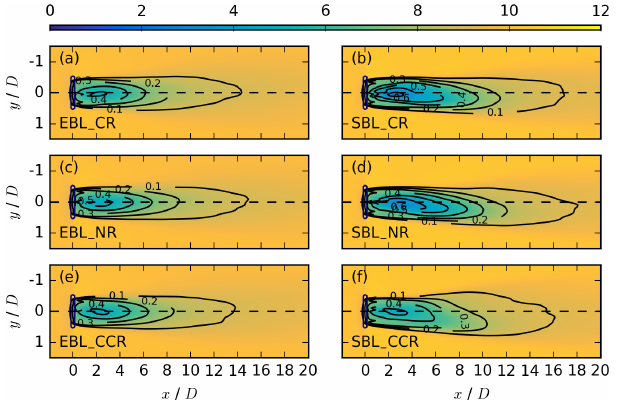
in Figure 9. Coloured contours of the streamwise velocity u i,j,k ∗ metres per second at z h = 125m with index k ∗ , averaged over the last 50min, for the same cases as in Fig. 8. The black contours rep- resent the velocity deficit VD i,j,k at the same vertical location. ∗